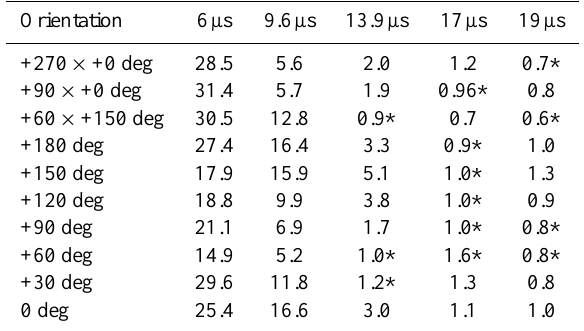
Table 3. Peak voltages (in mV) for indicated reflections as a func- tion of angle. Asterisks indicate very low observed voltage sig-